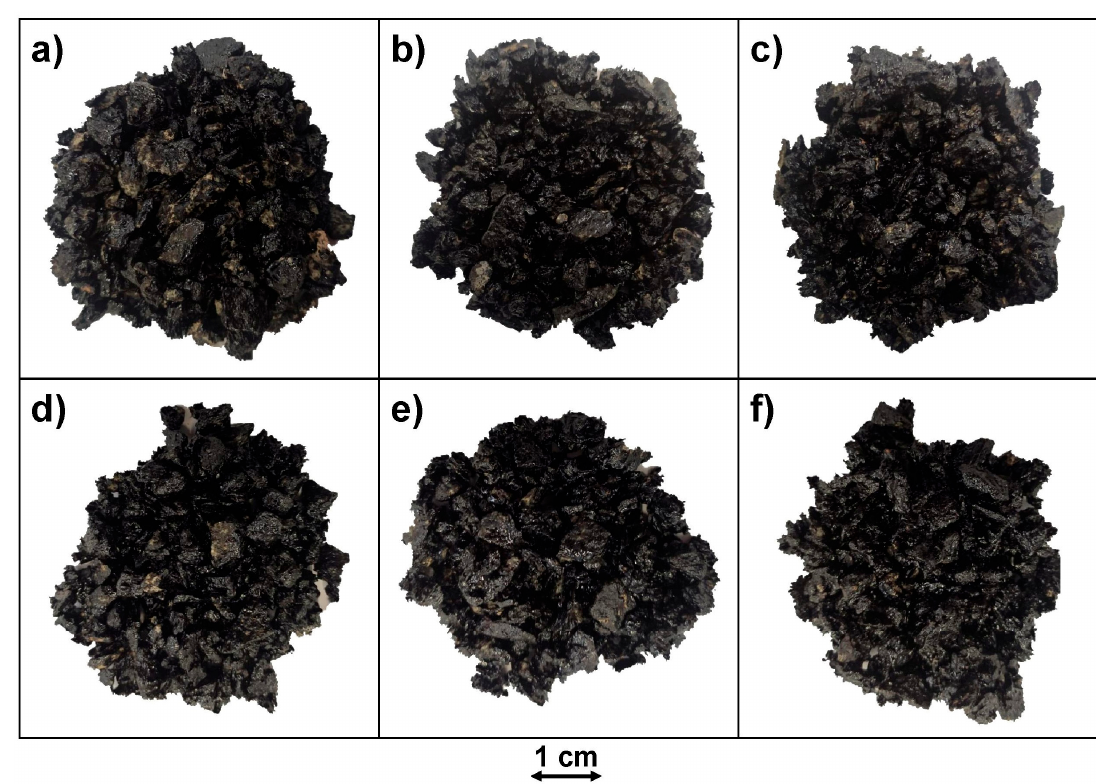
Figure 5. Coating test of bituminous mixtures conformed with ophite coarse and fine aggregate and biomass bottom ash filler AOFA. ( a ) 6.5% residual bitumen, ( b ) 7% residual bitumen, ( c ) 7.5% residual bitumen, ( d ) 8% residual bitumen, ( e ) 8.5% residual bitumen, and ( f ) 9% residual bitumen.